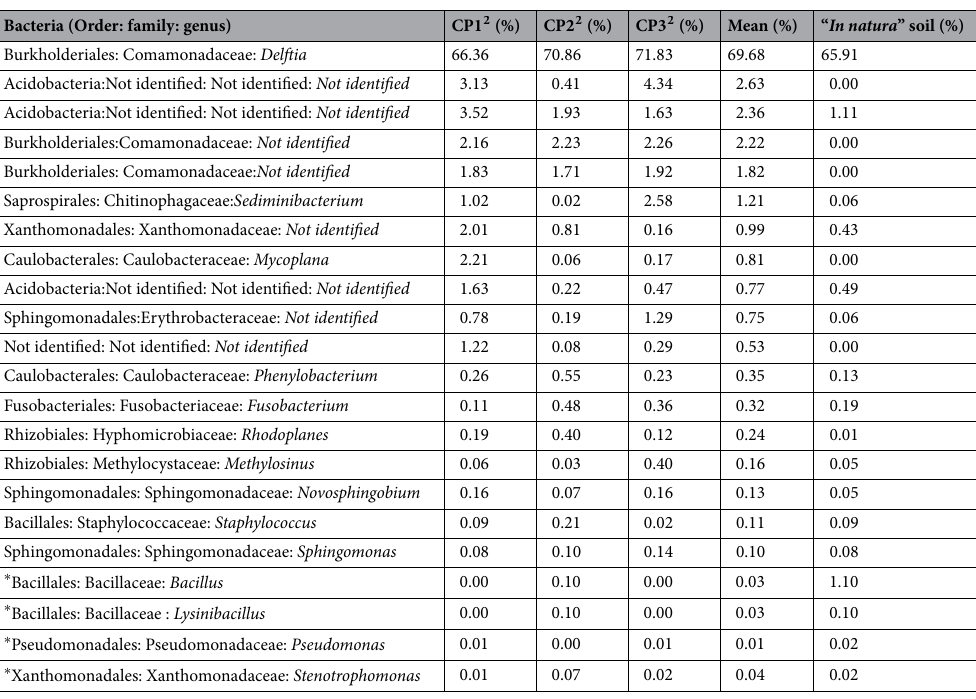
Table 7. Bacteria genera